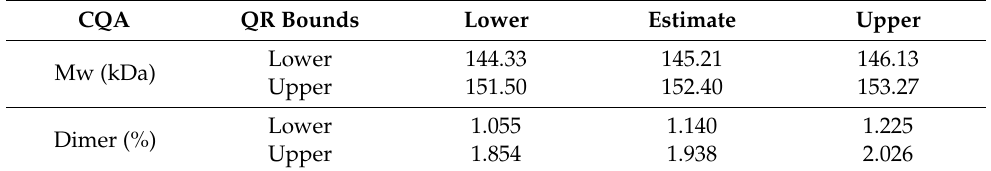
Table 3. Estimates and bootstrap 95% confidence intervals for QR estimated from variance